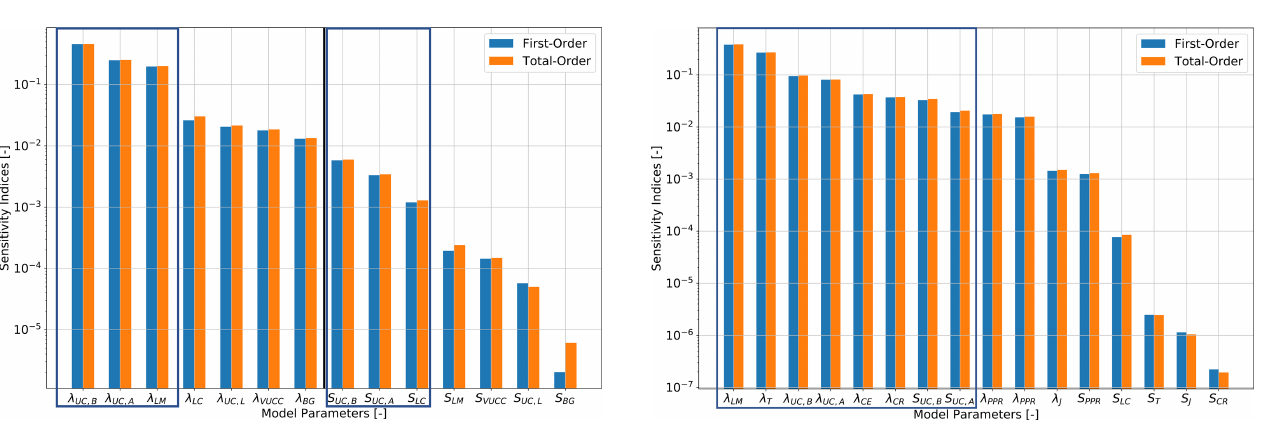
Figure 3. Global sensitivity indices for the analysis focused on the crustal layers of the Central European Basin System. The first-order indices are denoted in blue and the total-order indices in orange. Furthermore, we mark the parameters used in further analysis with blue rectangles, and the vertical black line denotes the separation between the thermal conductivities and radiogenic heat production. For the acronyms, please refer to Table A1.